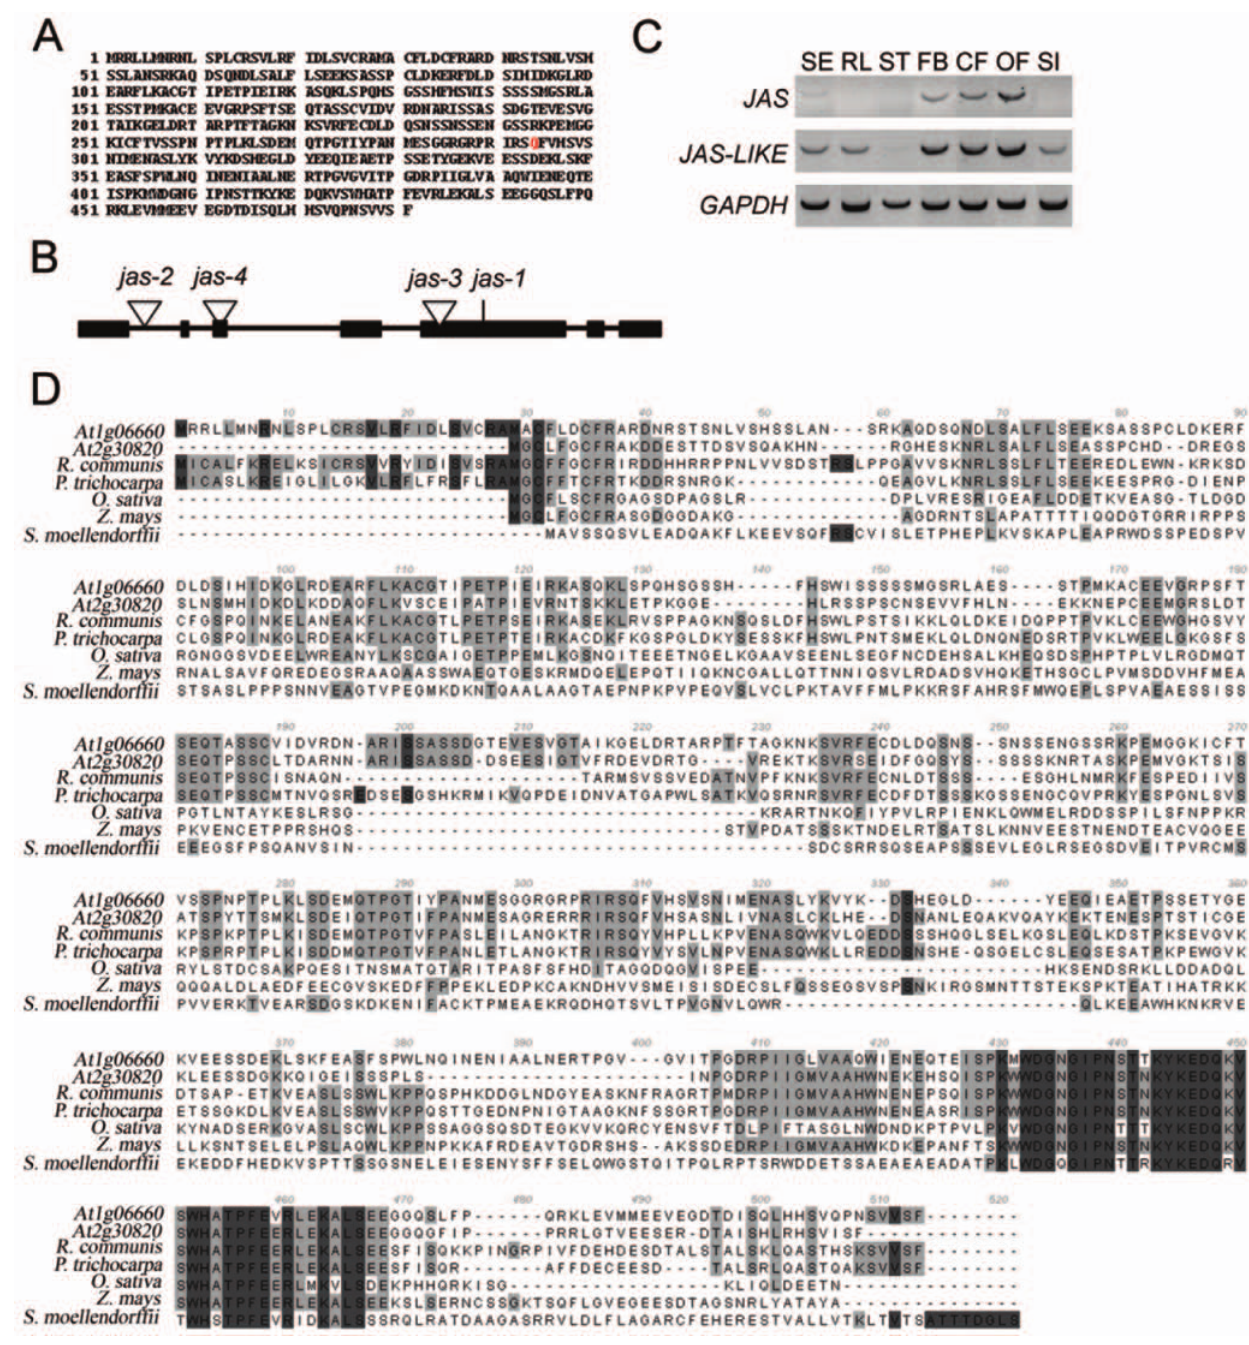
Figure 4. Structure of JAS gene and location of mutations. (A) Protein sequence of JAS with site of jas-1 mutation indicated in red. (B) Exon- intron structure of JAS locus, with exons marked by black boxes, introns by black lines. Positions of jas alleles are indicated. (C) Expression analysis of JAS and JAS_LIKE in different plant organs. SE, seedlings; RL, rosette leaves; ST, stem; FB, floral buds (stage 9 flower); CF, closed flower (stage 11 flower); OF, open flower (stage 13 flower); SI, silique. Flower stages were determined as described in [66]. (D) Multiple sequence alignment showing regions of highest sequence conservation among plant JAS proteins. Dark grey and light gray shading symbolizes 100% and over 50% sequence conservation at that position, respectively. Included in the alignment are JAS homologs from dicots Arabidopsis thaliana and Populus trichocarpa , from monocots Oryza sativa and Zea mays and from the lycophyte Selaginella moellendorffii .